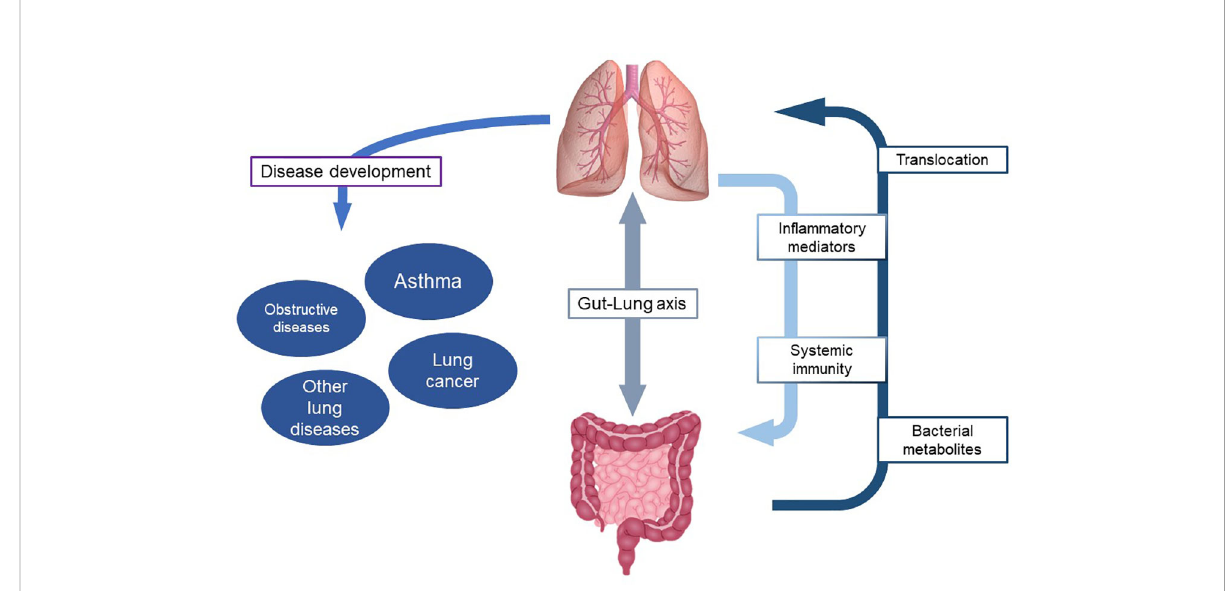
FIGURE 1 Role of microbiome in the interaction between gut and lung and development of respiratory